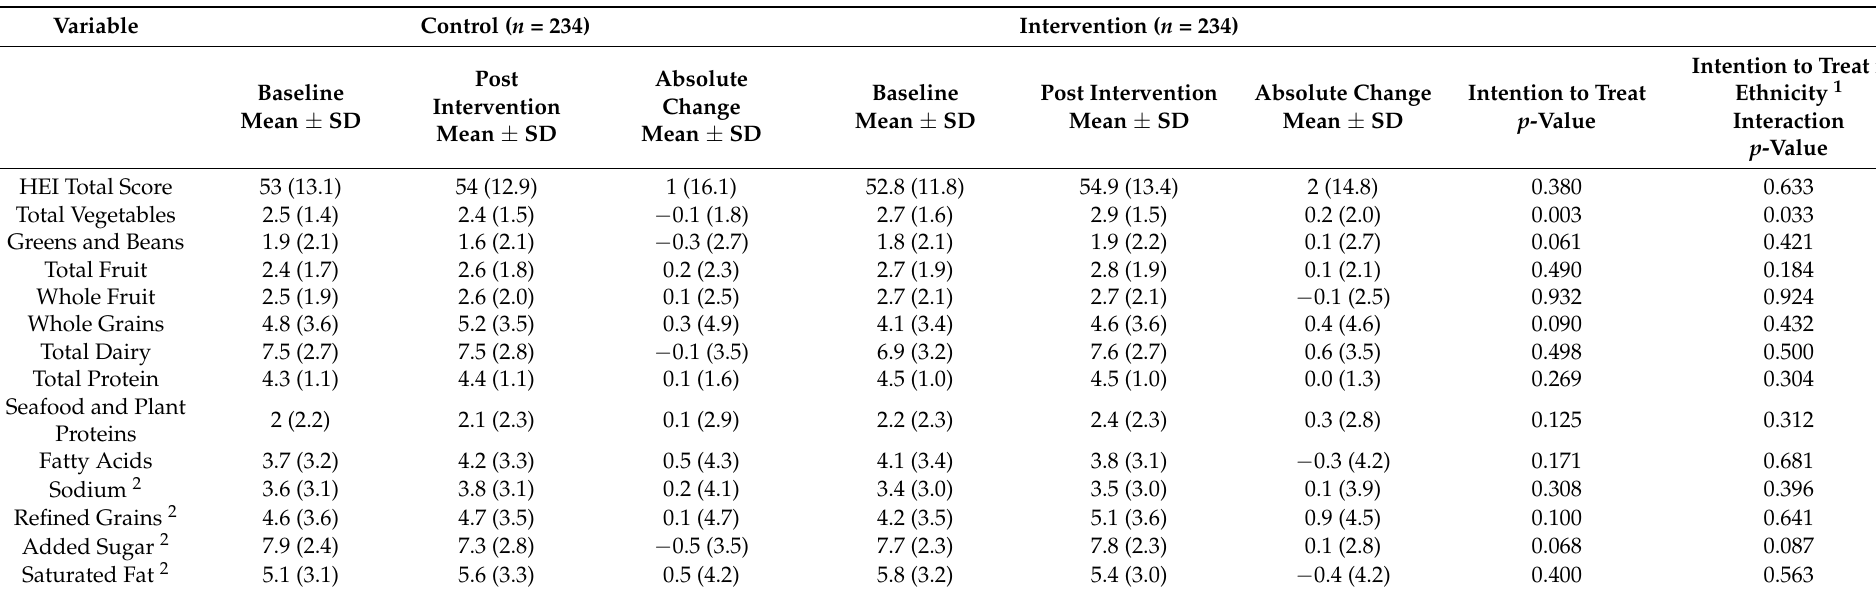
Table 2. Repeated Measures ANCOVA of Intent to Treat Effects of a School-Based Cooking, Gardening, and Nutrition Intervention on Healthy Eating Index—2015 Total and Component Scores in Low-Income Elementary Aged